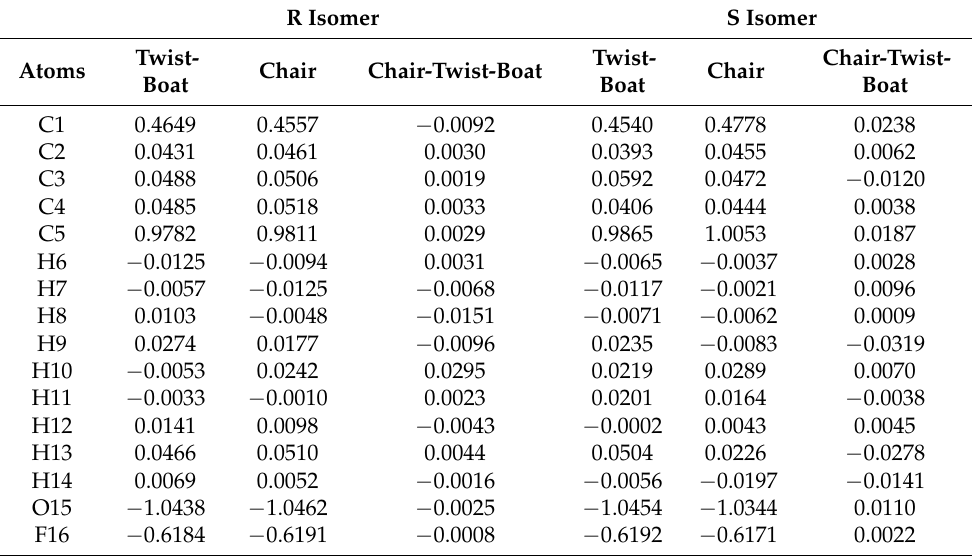
Table 7. QTAIM charges (in electron, e) for the R and S isomers. R Isomer S Isomer Twist- Atoms Chair Chair-Twist-Boat Boat